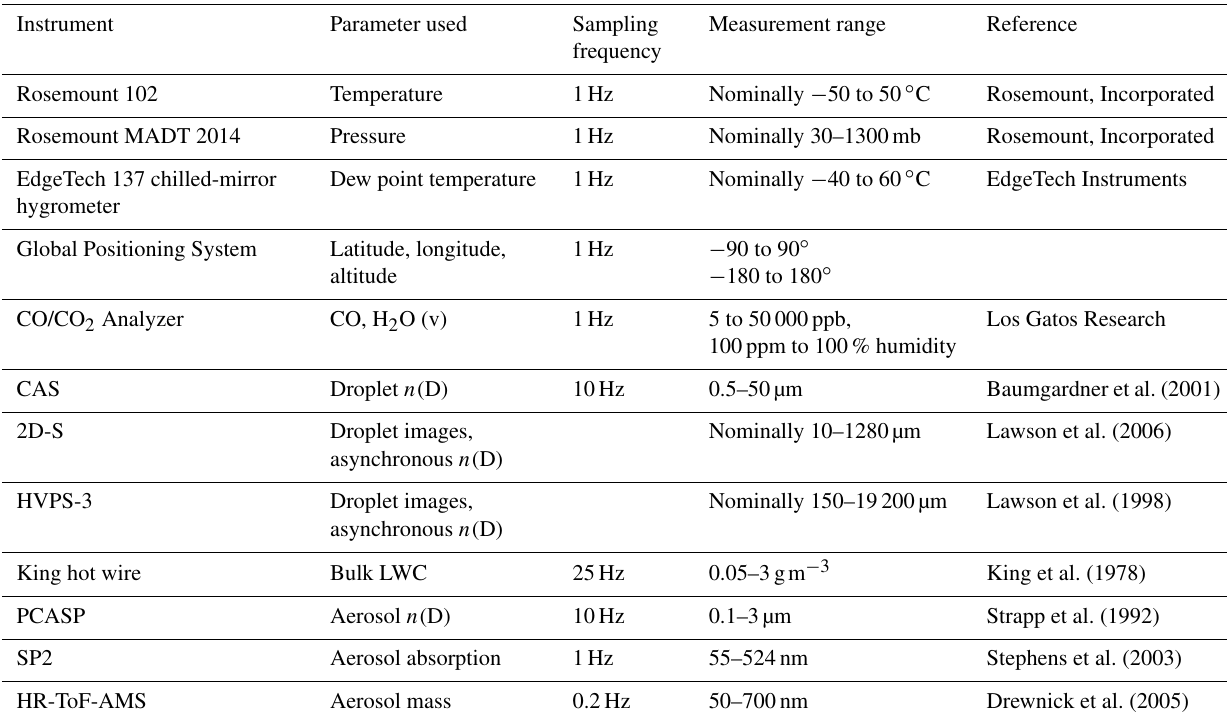
Table 1. The main parameter used, sampling frequency, and measurement range for in situ instruments installed on the P-3 research aircraft and used within this